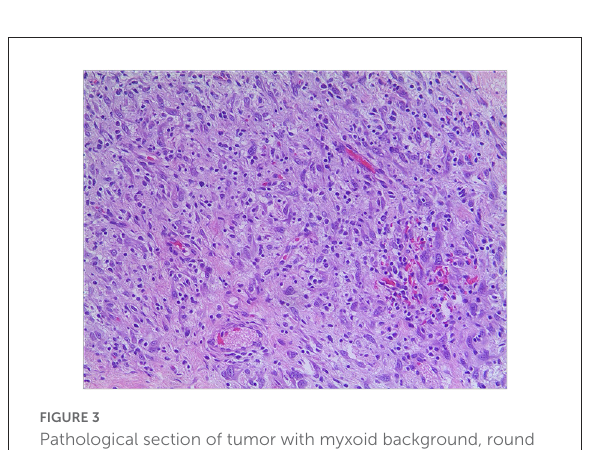
FIGURE3 Pathological section of tumor with myxoid background, round and polygonal cells (hematoxylin-eosin, original magnification